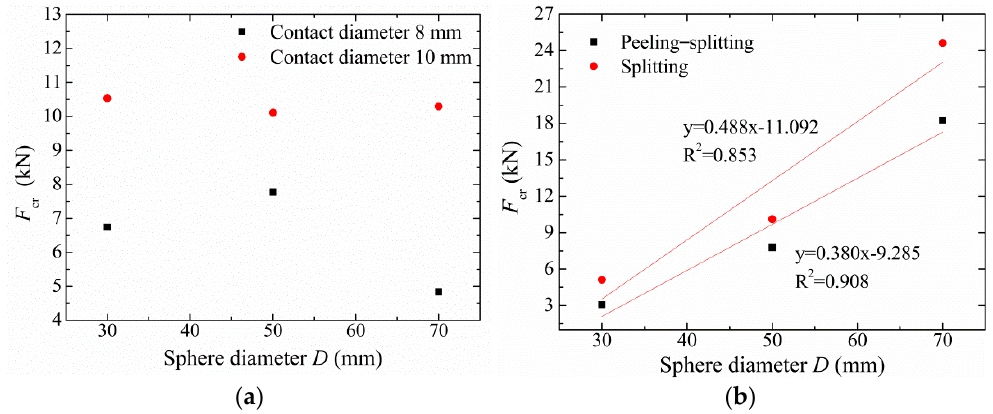
Figure 14. Relationship between critical normal force F cr and sphere diameter D : (a) contact diam- eters of 8 mm and 10 mm; (b) breakage modes of peeling–splitting and splitting.